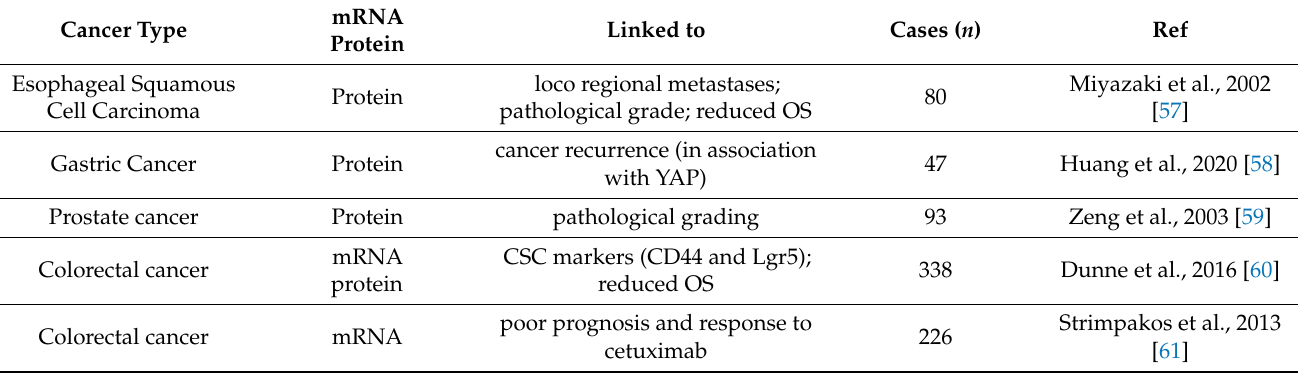
Table 1. Examples of EphA2 overexpression in human malignancies, with its significance and the number of cases analyzed. mRNA Cancer Type Linked to Cases ( n ) Ref Protein Esophageal Squamous loco regional metastases; Protein Cell Carcinoma Gastric Cancer Protein Prostate cancer Colorectal cancer Colorectal